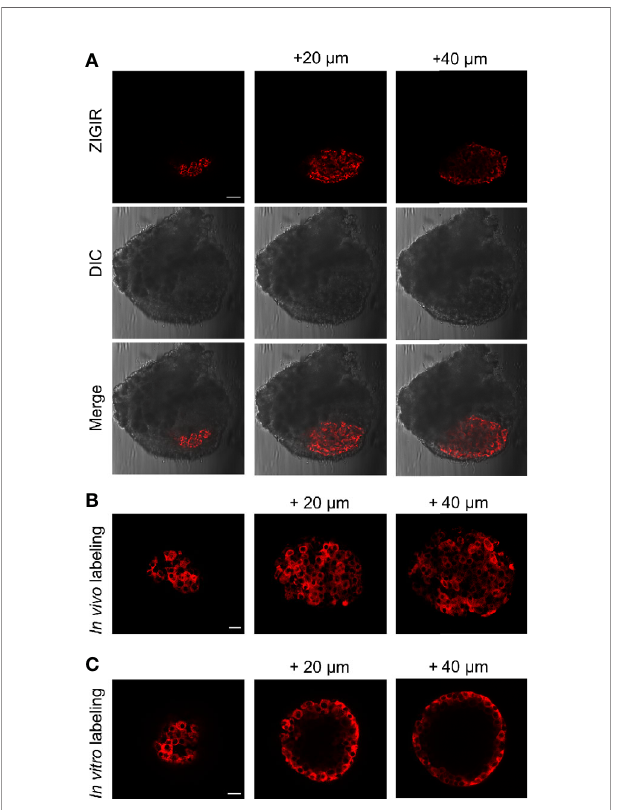
FIGURE 7 | In vivo systemic delivery of ZIGIR selectively labeled pancreatic endocrine cells throughout entire islets. (A) ZIGIR selectively labeled rat islet cells after tail vein injection. Confocal images of a pancreatic tissue from a rat injected with ZIGIR. Three consecutive confocal sections 20 µm apart along the z-axis were shown. ZIGIR signal was seen only in the islet but not the exocrine cells. Scale bar = 100 µm. (B, C) ZIGIR labeled mouse islet cells throughout the islet after tail vein injection (B) , but only labeled the outer cell layer when it was applied to the isolated mouse islets in vitro (C) . Three consecutive confocal sections of ZIGIR-labeled islets were shown. Scale bar = 20